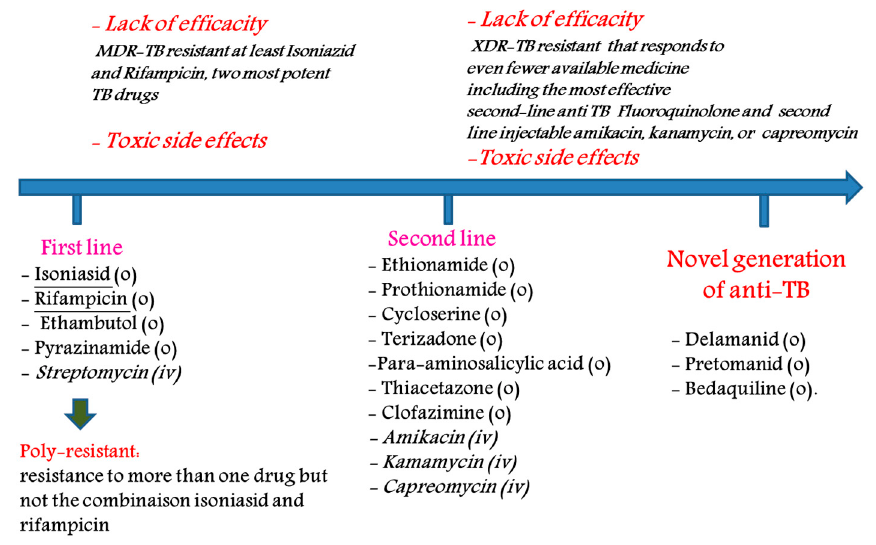
Figure 1. Main treatments to tackle tuberculosis (o: oral, iv : intravenous administration).